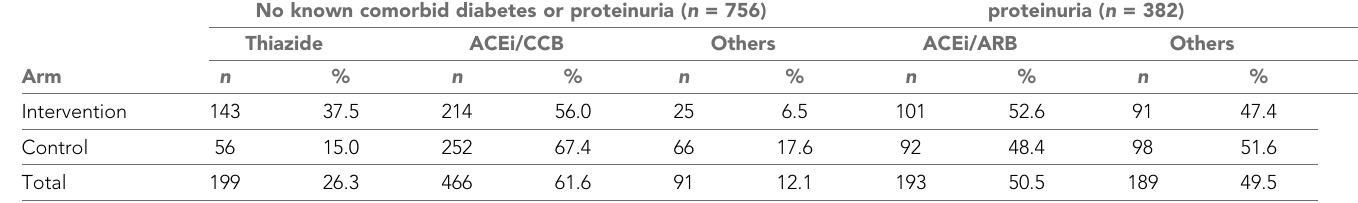
Table 1. Prescription of antihypertension